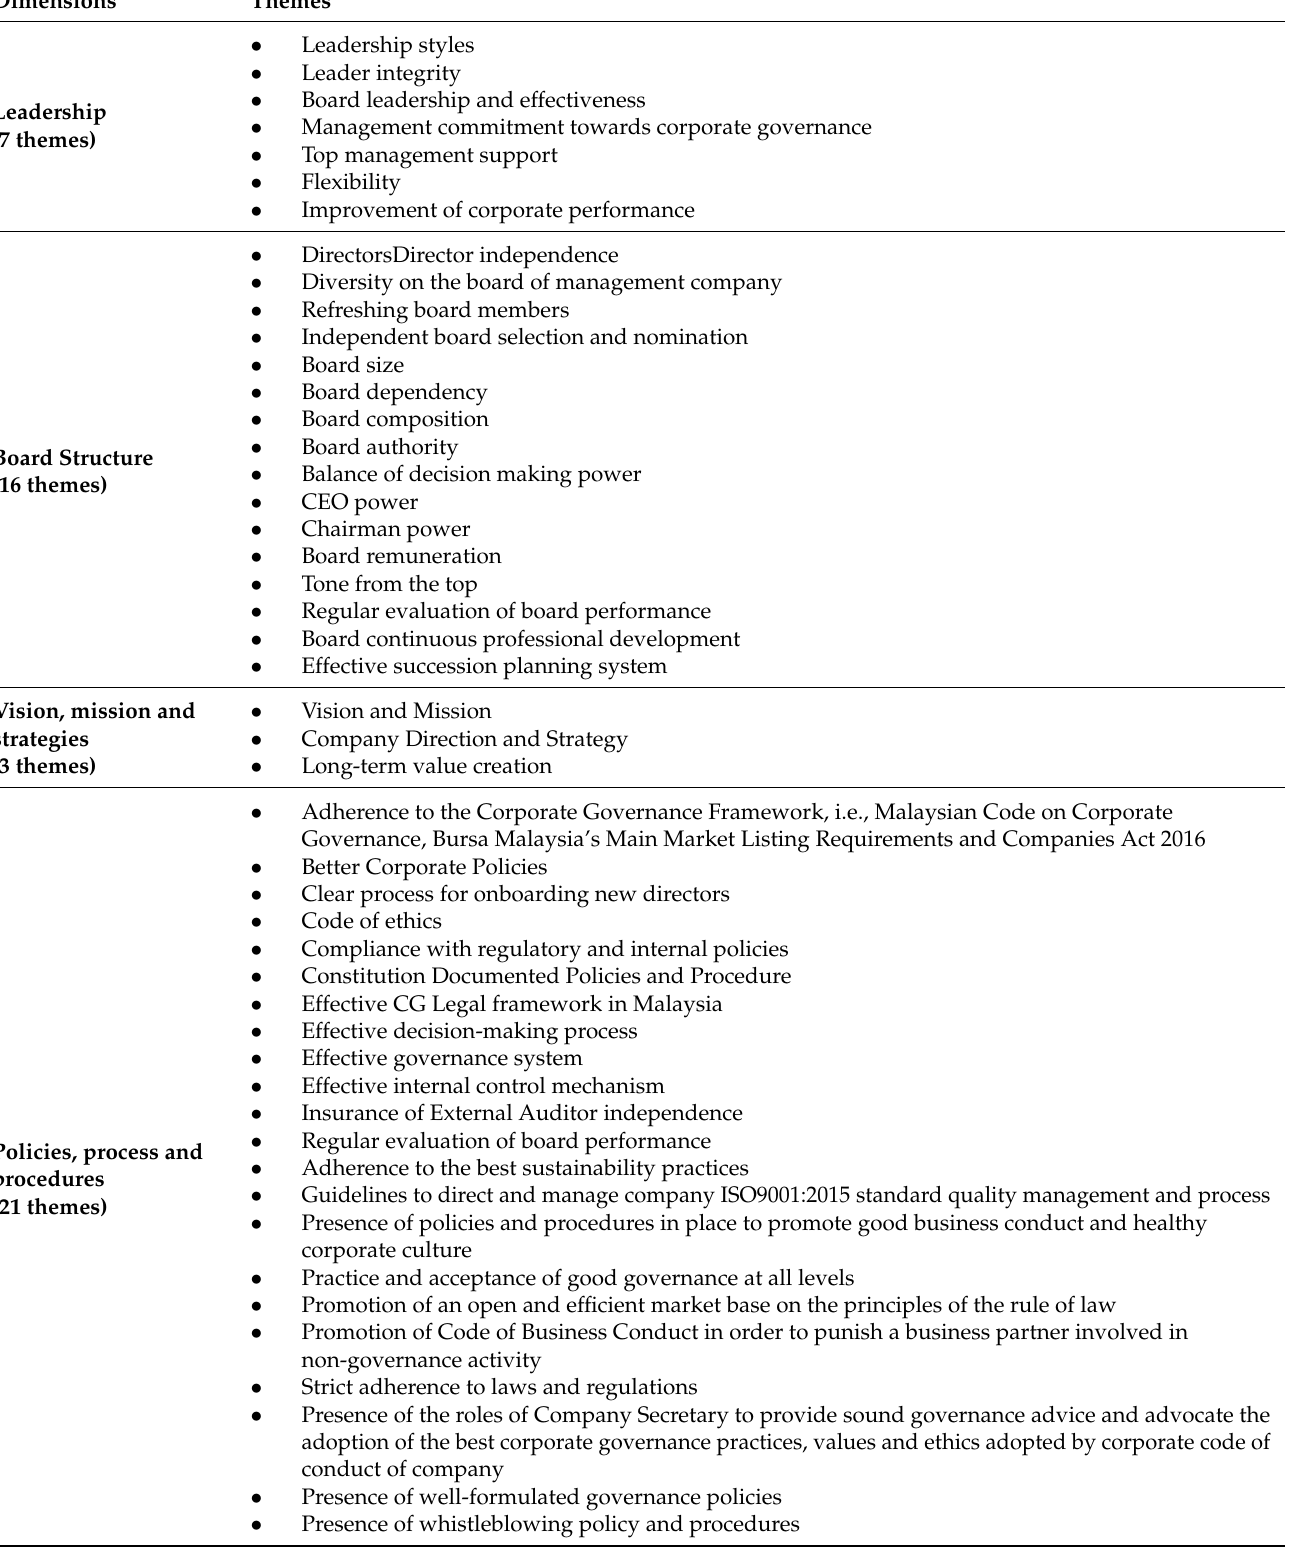
Table 2. Consolidation of Round One Delphi